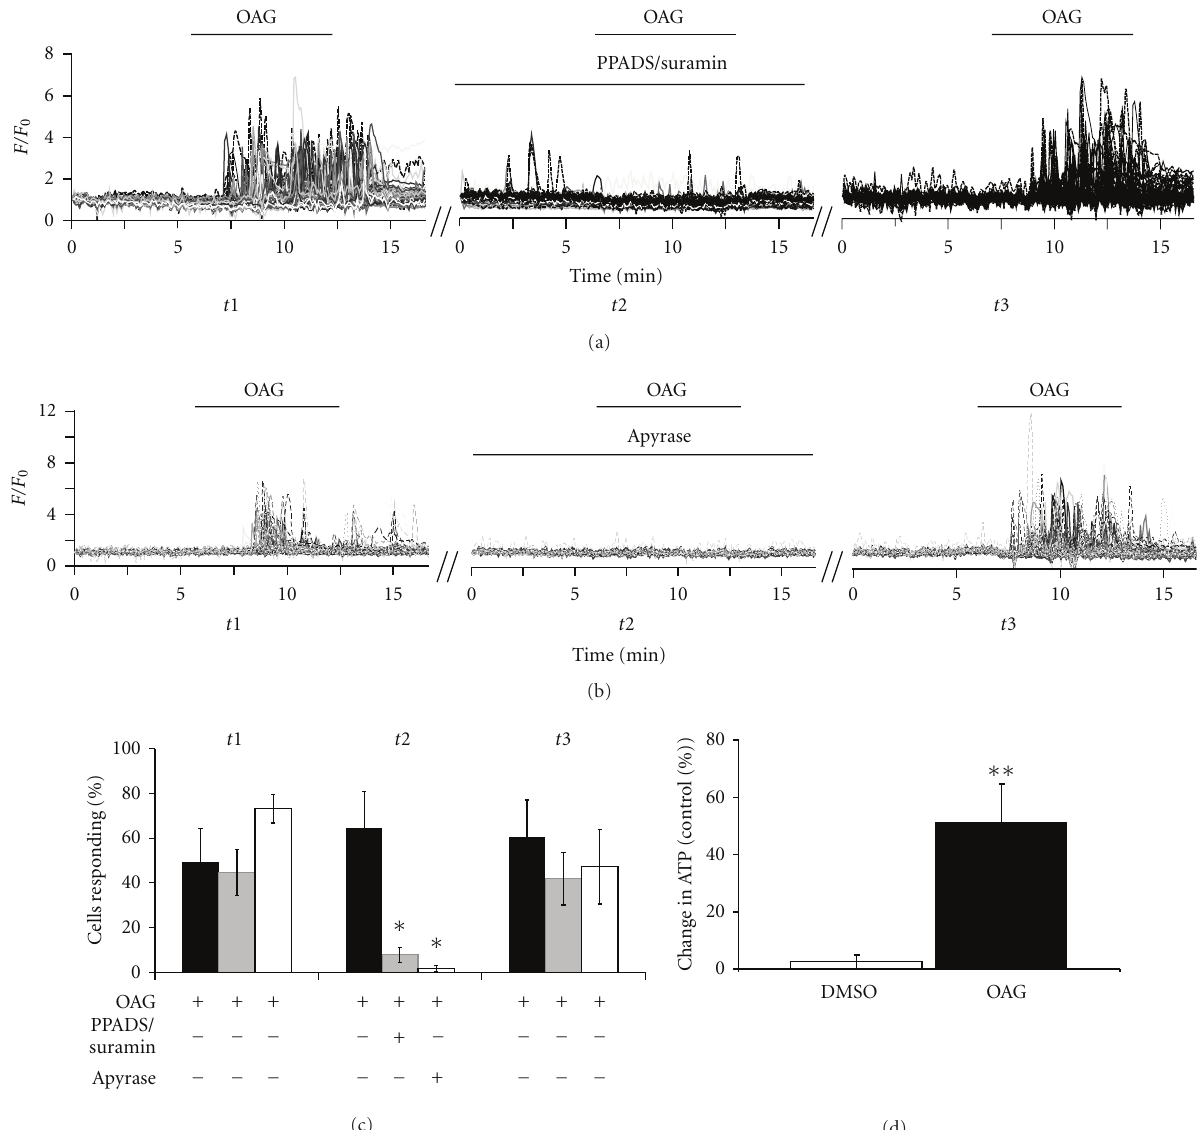
Figure 2: OAG-dependent calcium oscillations in cultured astrocytes are a result of ATP release. (a) During the first imaging period ( t 1) a baseline response to 100 µ M OAG is established in astrocyte cultures. Data are shown as individual cell traces of F / F 0 (fold change) over time (minutes). Blocking astrocytic ATP receptors during the second imaging period ( t 2) with a combination of the P2 receptor inhibitors PPADS and Suramin greatly reduces the response to 100 µ M OAG. This blockade is reversible, after washout the response to 100 µ M is reestablished in the third imaging period ( t 3). Diagonal lines between imaging session indicate a wash period of 15 minutes occurring between imaging sessions. (b) Addition of the enzyme apyrase, which degrades ATP to ADP, and ADP to AMP, during t 2 abolishes the astrocytic response to 100 µ M OAG. (c) Quantification demonstrates a significant decrease in the percentage of astrocytes responding with calcium oscillations to OAG stimulation with either the blockade of ATP receptors (PPADS/Suramin; control n = 5, PPADS/Suramin n = 8; t 2 P = 0 . 02) or the degradation of extracellular ATP (Apyrase; control n = 5, apyrase n = 4; t 2 P = 0 . 02). (d) ATP assays performed with the luciferin- luciferase reaction demonstrate the release of ATP from cultured astrocytes treated with OAG, compared to controls with DMSO added (DMSO n = 29, OAG = 27, P = 0 .